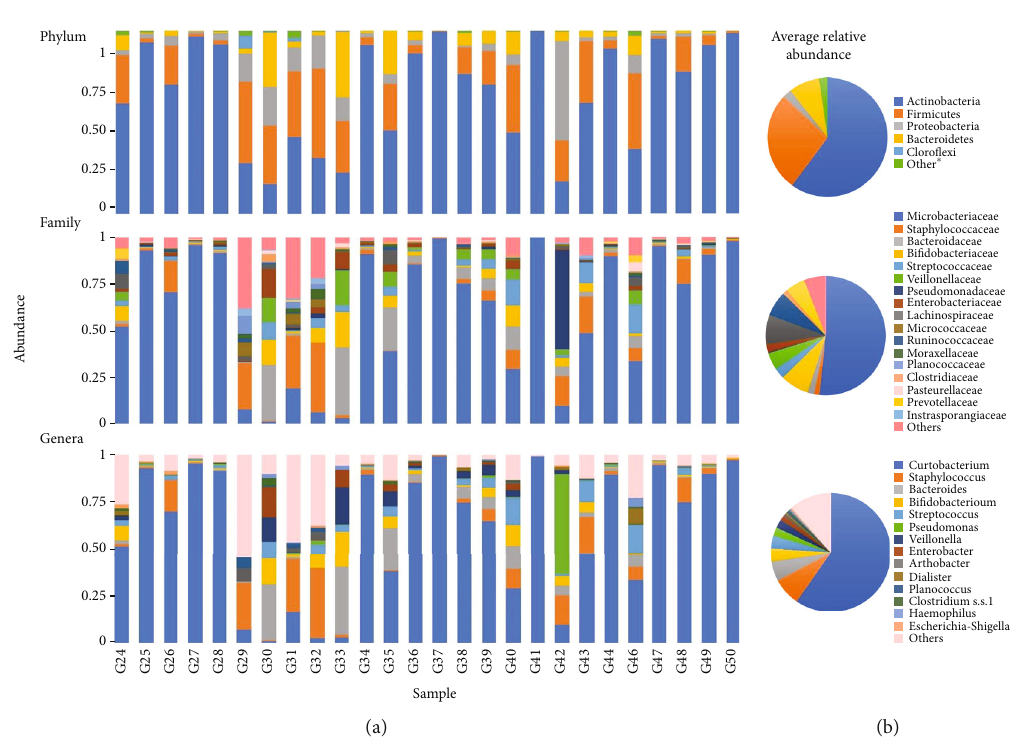
Figure 1: Relative abundance of the bacterial population analyzed from the sequencing of the 16S rRNA gene in DNA samples isolated from goat milk at the phylum, family, and genus level. (a) Bar chart of relative abundances of the bacteria across each sampled goat milk ( n = 26 ). (b) Pie chart of the average relative abundances of the bacteria. ∗ Bacteria with relative abundance higher than 0.5% (at phylum level) and 10% (at the family and genera levels) are visualized (taxa lower than 1% are displayed as “ others ”